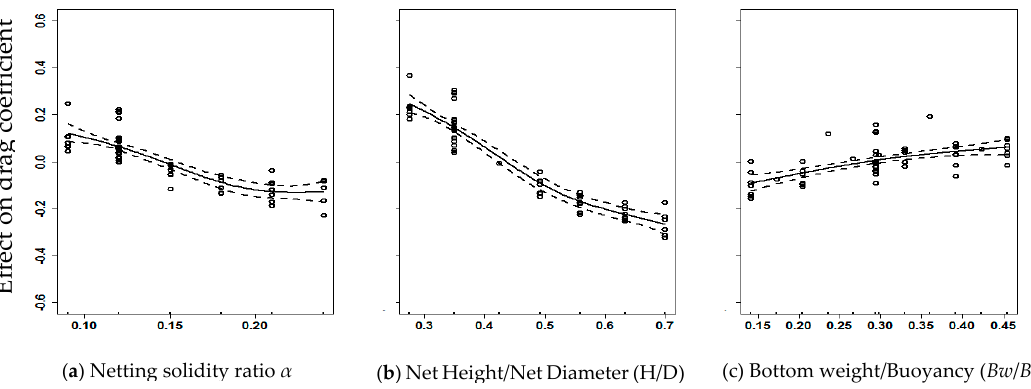
Figure 13. The relationship between design factors and drag coefficient on the generalized additive (GAM) model. (The y-axis represents the partial effect of each variable; Dashed lines indicate 95% confidence bounds; Solid lines are smooth curves).